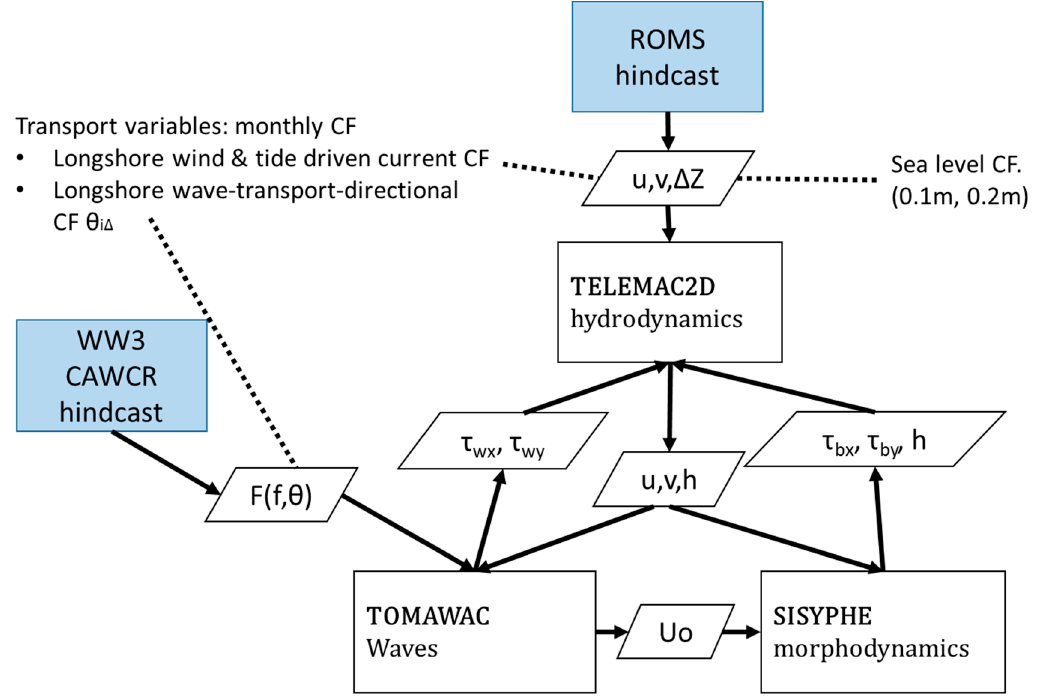
Figure 3. LCM Nearshore model configuration. The flow chart corresponds to the “LCM NEARSHORE” process at the bottom of Figure 2. Equation (1) was used to apply the CF downscaling method to both the ROMS hindcast longshore wind and tide driven currents and to rotate the WW3 2D spectrum by the wave-transport-directional CF. The addition of 0.1 or 0.2 m to the hindcast sea level simulated the effect of sea level rise.